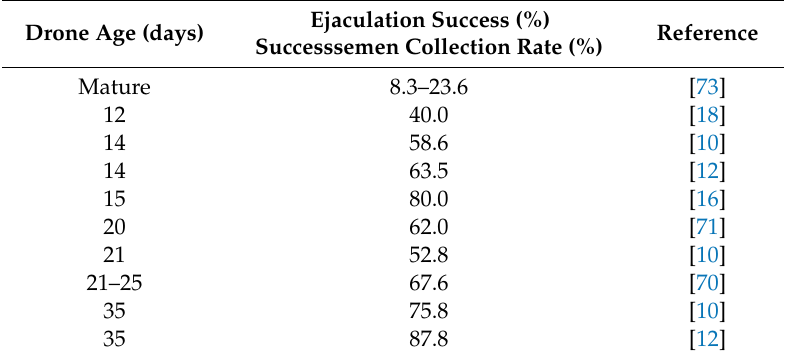
Table 2. Percentage of drones ejaculating semen after manual